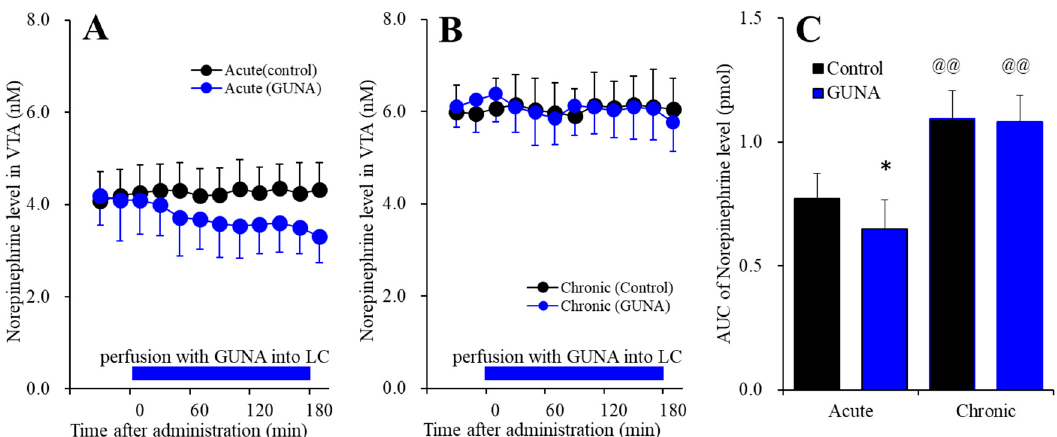
Figure 3. Effects of acutely local administration (perfusion with) 200 nM guanfacine into the LC on extracellular norepinephrine level in the VTA, after the systemically chronic administration of guanfacine (0 or 0.12 mg/kg/day for 14 days). Panel ( A ) indicates the effects of perfusion with 200 nM guanfacine into the LC after chronic administration of guanfacine (0 mg/kg/day) for 14 days (acute effects). Panel ( B ) indicates effects of 200 nM guanfacine after systemically chronic administration of guanfacine (0.12 mg/kg/day) for 14 days (chronic effects). Ordinates: mean±SD (n = 6) of extracellular norepinephrine level (nM), abscissa: time after administration of perfusion with guanfacine into the LC (min). Blue bars: perfusion of 200 nM guanfacine into LC. Panel ( C ) indicates the AUC20–180 min values of extracellular norepinephrine level during perfusion with guanfacine (from 20 to 180 min). Ordinates: mean±SD (n = 6) of AUC20–180 min values of extracellular norepinephrine level (pmol). Black and blue columns indicate respective control and perfusion of guanfacine of AUC values of norepinephrine levels. When the effects of guanfacine were statistically significant compared using MANOVA, the data were analysed using Tukey’s post hoc test. * p < 0.01, compared with control. @@ p < 0.01: compared with acute effects of guanfacine.